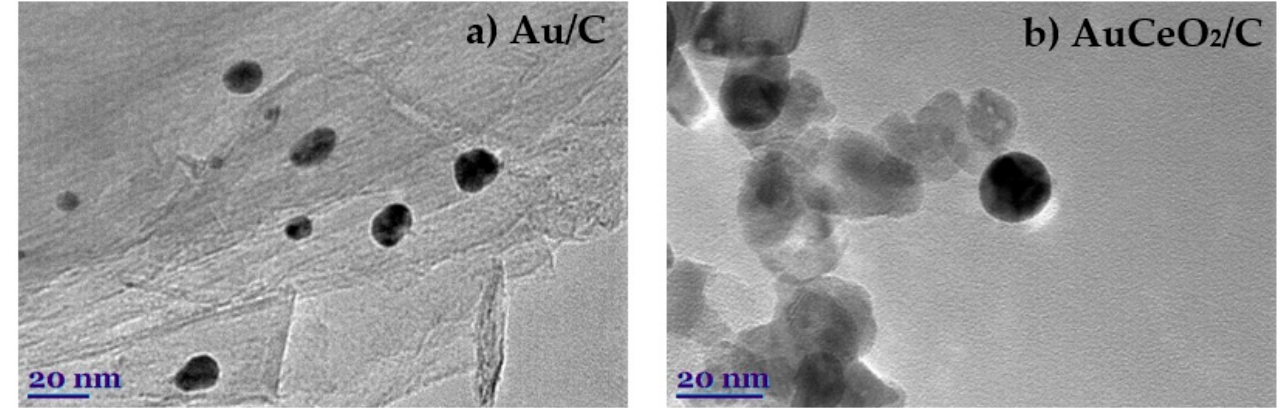
Figure 1. TEM images of the Au/C ( a ) and AuCeO 2 /C ( b ) catalysts prepared by the microwave irradiation method. It has been determined that Au in a metallic phase for both Au/C and AuCeO 2 /C